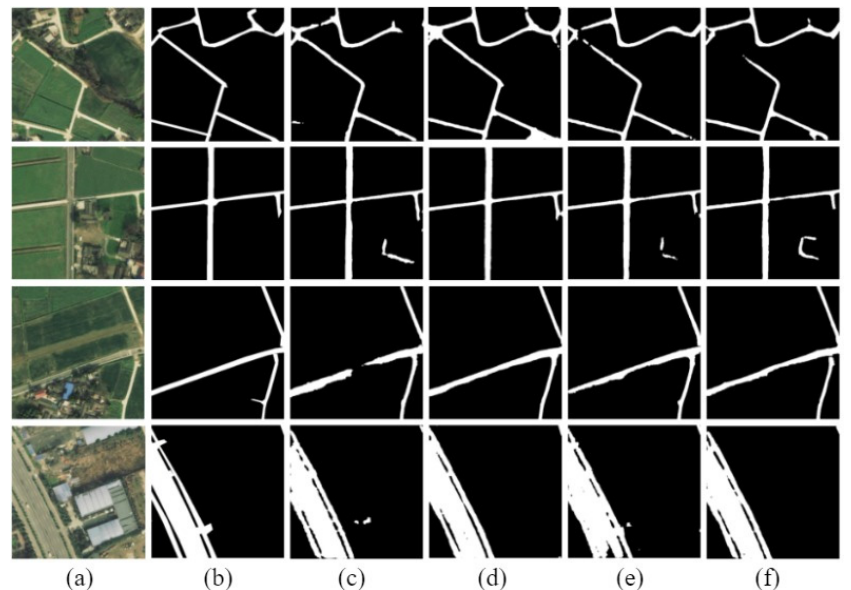
Figure 11. Comparison results of simple scene experiment. ( a ) Original image; ( b ) label image; ( c ) D-